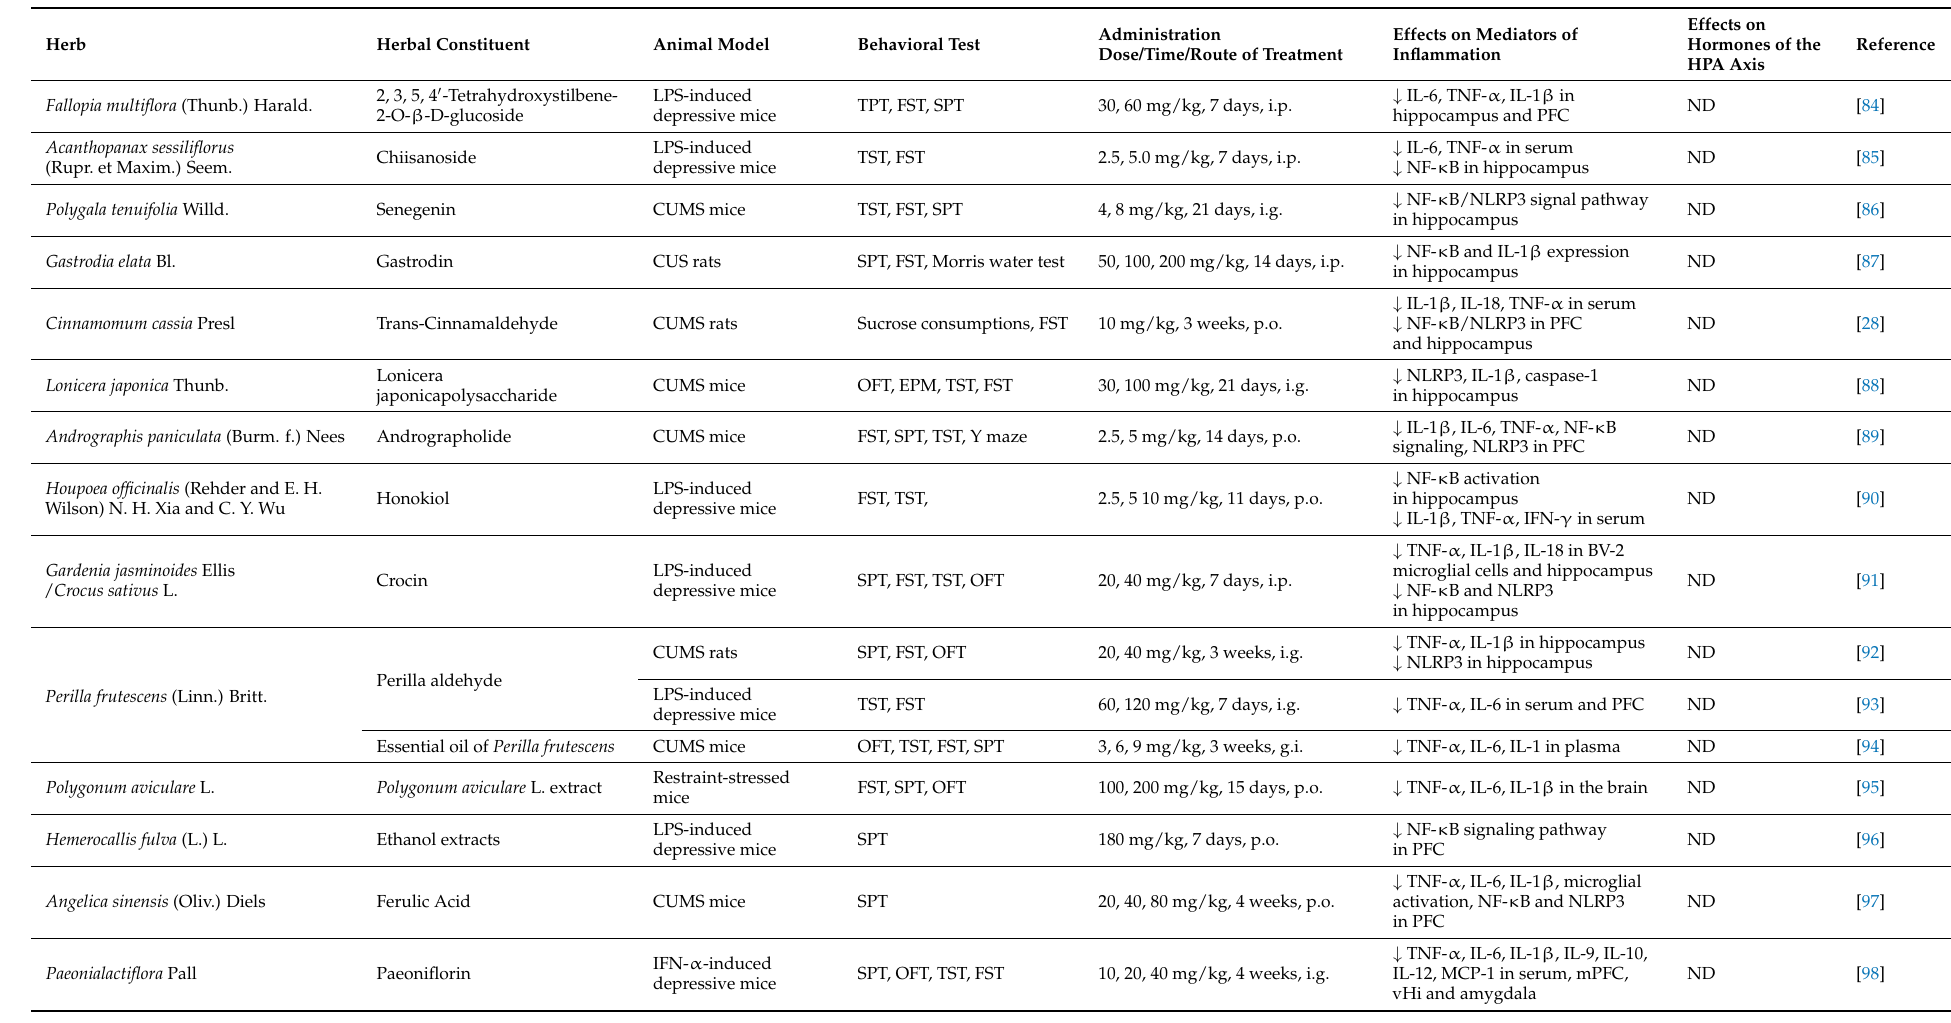
Table 1. Constituents of CHM that modulate the release of HPA axis hormones and exhibit anti-inflammatory and antidepressant-like activities in animal models of depression. Herb Herbal Constituent Fallopia multiflora (Thunb.)